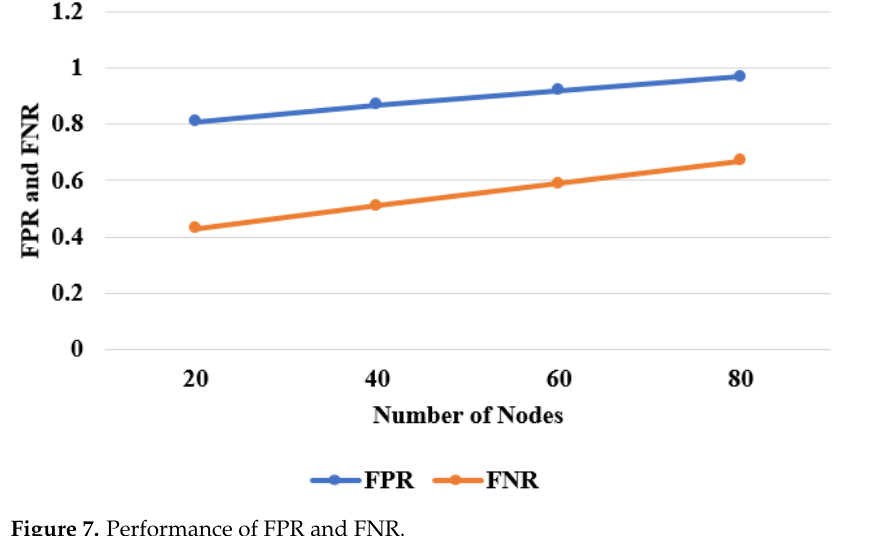
Figure 7. Performance of FPR and FNR. Table 4. Performances of FPR and FNR.